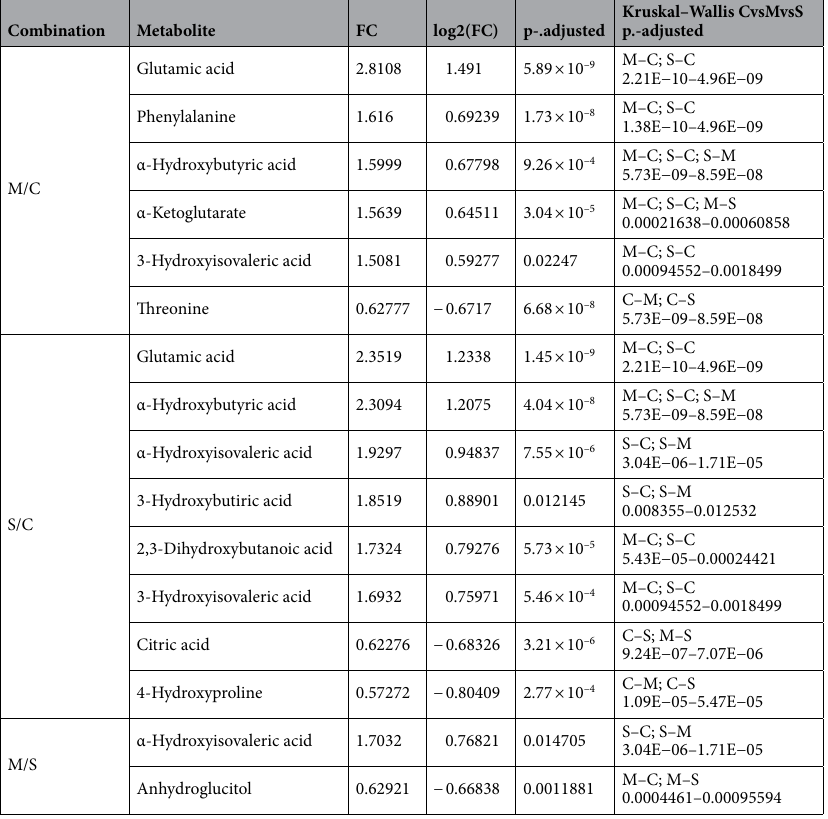
Table 2. Comparison of metabolites with fold changes > 0.5 according to disease severity. Fold-change was calculated using Metaboanalyst 5.0. p values were calculated using the Mann–Whitney test for MvsS and Kruskal Wallis test for multiple comparisons (CvsMvsS). Comparisons are included as follows: mild COVID- 19 versus controls (MvsC); severe COVID-19 versus controls (SvsC) and severe versus mild COVID-19 (SvsM).